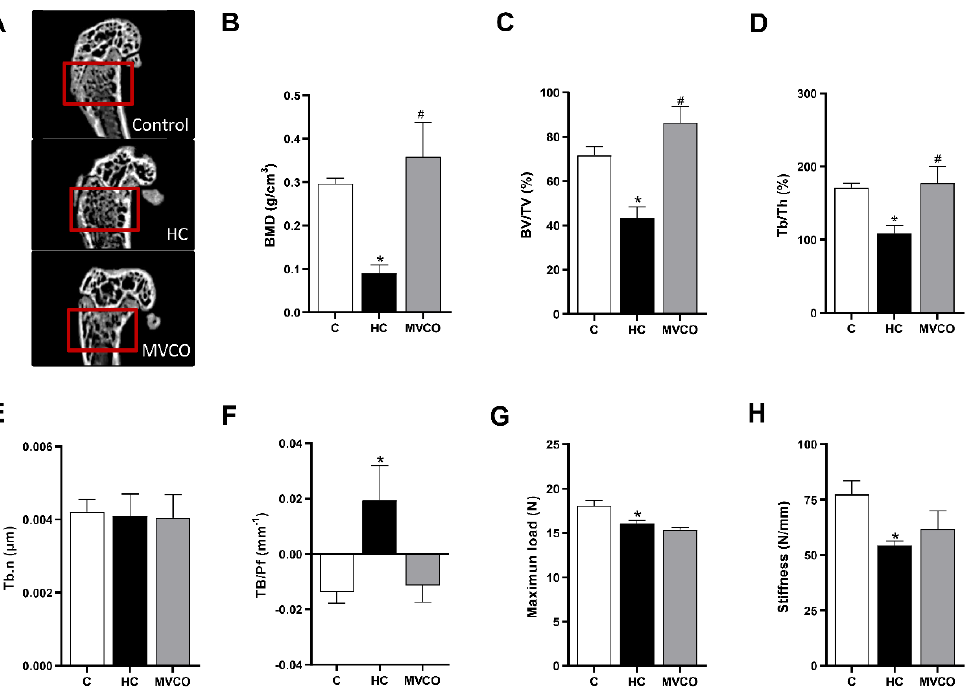
Figure 3. Micro-CT analysis of trabecular bone in the femur. ( A ) Representative femur images (small red squares represent the analyzed region on micro-CT). ( B ) Bone mineral density (BMD), ( C ) trabecular bone volume fraction (BV/TV), ( D ) trabecular thickness (Tb.Th), ( E ) trabecular number (Tb.N), ( F ) trabecular pattern factor (Tb.Pf), ( G ) bone maximum load and ( H ) stiffness of femur in mice fed chow diet (C), high refined carbohydrate-containing diet (HC), and HC diet supplemented with 3000 mg/kg body weight of virgin coconut oil (MVCO). Values are means ± SEM ( n = 5). * compared with the control (C) group ( P < 0.05); # compared with HC group ( P < 0.05).